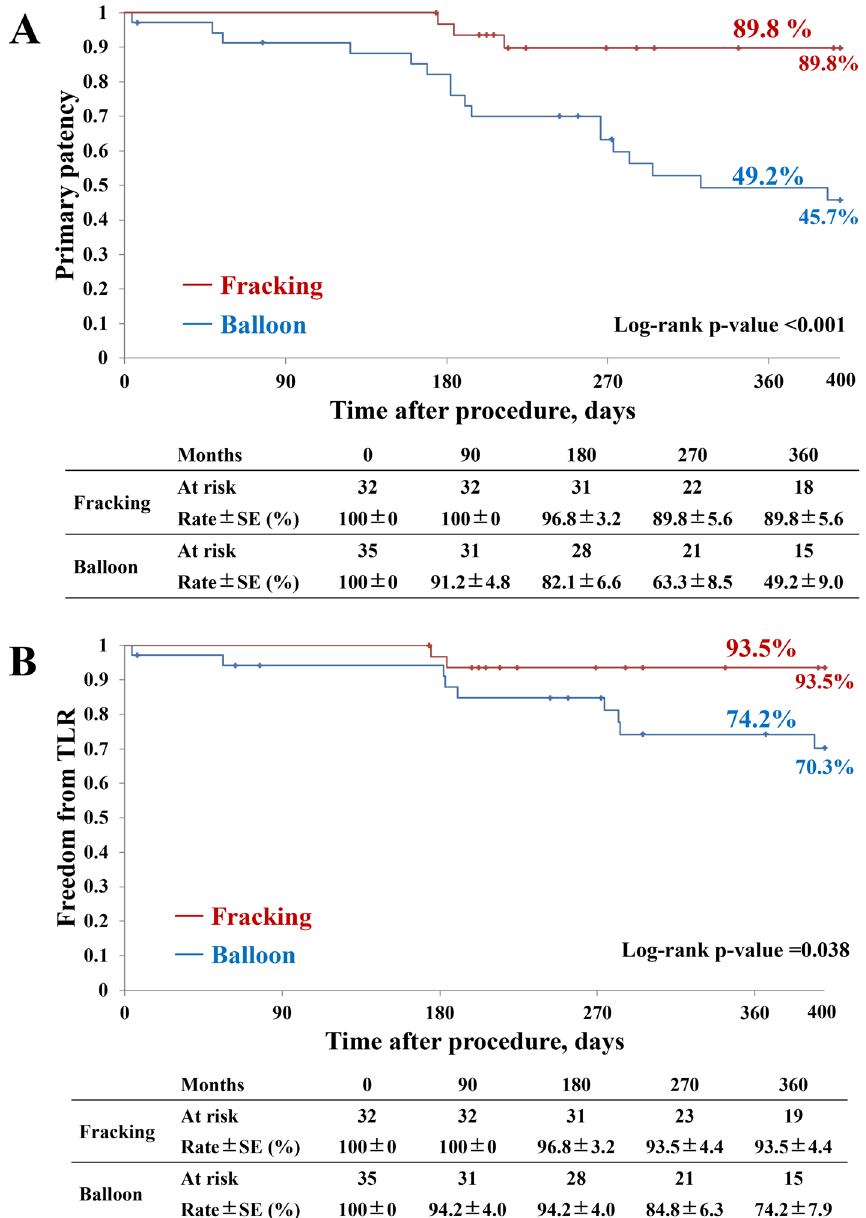
Fig. 2 Comparison of primary patency and freedom from TLR between fracking and conventional balloon angioplasty. A Primary patency and ( B ) freedom from target lesion revascularization rate for up to 1 year and 1 month after the fracking and balloon angioplasty procedures are shown. The figures show that both primary patency and freedom from TLR rates were significantly higher in the fracking group than in the balloon